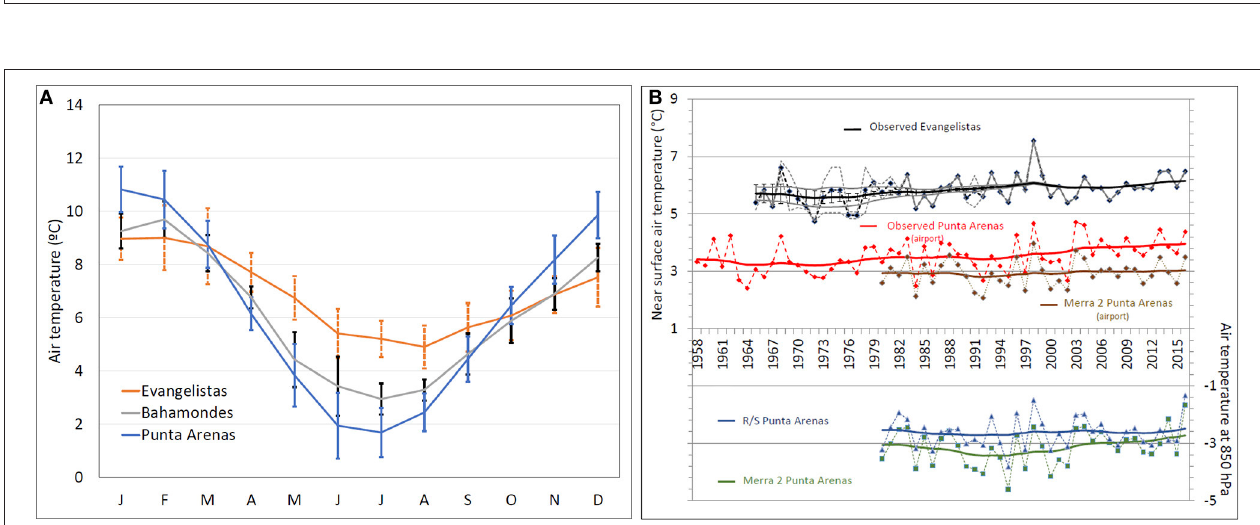
FIGURE 6 | (A) Annual cycle of mean air temperature at Punta Arenas Airport, Evangelistas and Bahamondes stations for the 2000–2016 period. Vertical lines are the 1st standard deviation. (B) Extended winter (April–September) mean air temperatures (dashed lines) at Evangelistas (upper curve, black) and Punta Arenas airport (lower curve, red) over the period 1958–2016. Thick lines are the result of an exponential filter applied to smooth the annual data (squares). Dashed (solid) gray curves in the annual (filtered) Evangelistas data are the lower and upper boundary of the sum of the 1st standard deviation of the missing months which were replaced by their respective monthly averages. Brown solid and dashed lines are the near surface air temperature as simulated by the MERRA-2 model at the nearest gridpoint from Punta Areans. (C) Winter mean air temperature at 850 hPa measured by the radiosonde (R/S) at Punta Arenas (blue lines) and simulated by the MERRA-2 model for the nearest gridpoint from Punta Arenas (green lines). Solid lines are the smooth behavior after applying the exponential filter, while dashed lines are the interannual variability. MERRA-2 data are available from 1980 onward.